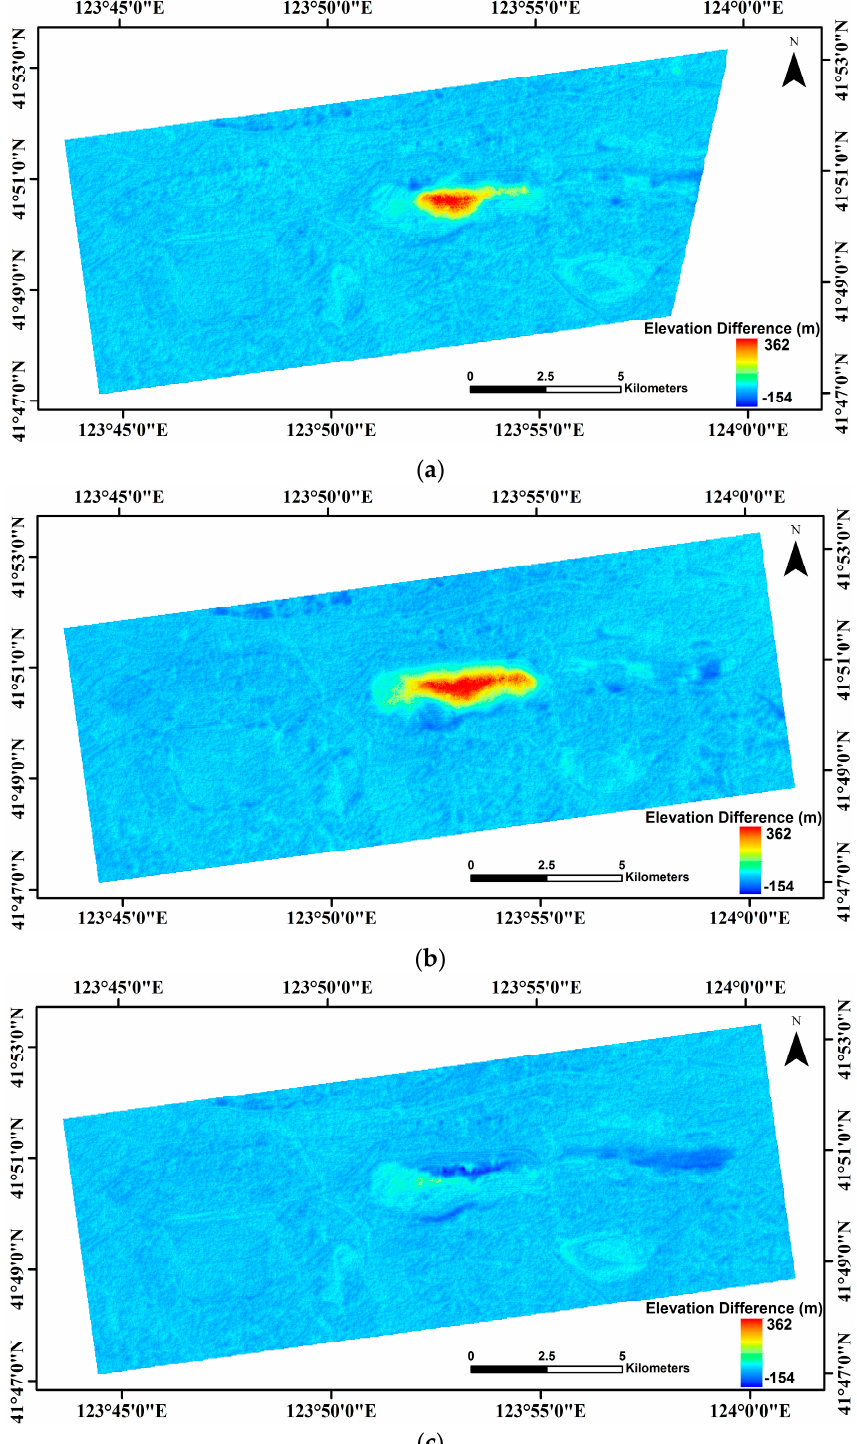
Figure 6. Overall ground deformation based on the elevation differences. ( a ) ZY-3 DSM in 2013 and ASTER GDEM; ( b ) ZY-3 DSM in 2014 and ASTER GDEM; and ( c ) ZY-3 DSM in 2015 and ASTER GDEM.